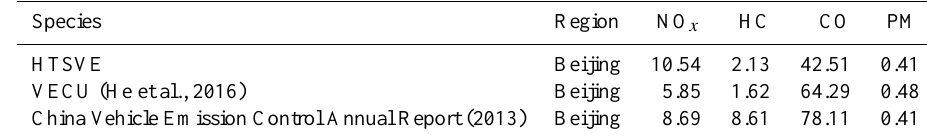
Table 4. Annual vehicle emissions in different reports (unit: 10 4 Mgyr − 1 ) .